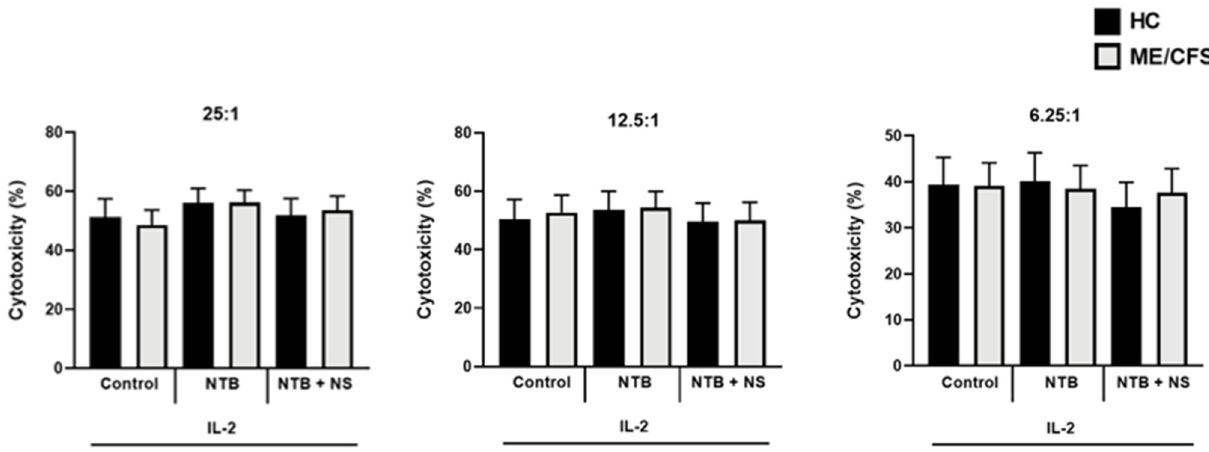
Figure 3. NK cell cytotoxicity post-IL-2 stimulation compared with TRPM7 drug treatments in HC vs. ME/CFS; n = 17 for HC and n = 17 for ME/CFS. After IL-2 (20 IU/mL) stimulation and TRPM7 agonist (20 IU/mL IL-2 + 25 µ M NTB) or antagonist (20 IU/mL IL-2 + 25 µ M NTB + 10 µ M NS8593) treatments for 24 h, no significant differences were observed within or between groups for each condition for any effector to target ratio. Data are represented as the mean ± SEM as determined by independent Mann-Whitney U tests. Abbreviations: healthy controls (HCs), interleukin-2 (IL-2), myelogenous leukemia target cell line (K562), myalgic encephalomyelitis/chronic fatigue syndrome (ME/CFS), natural killer (NK), NS8593 (NS), naltriben (NTB).